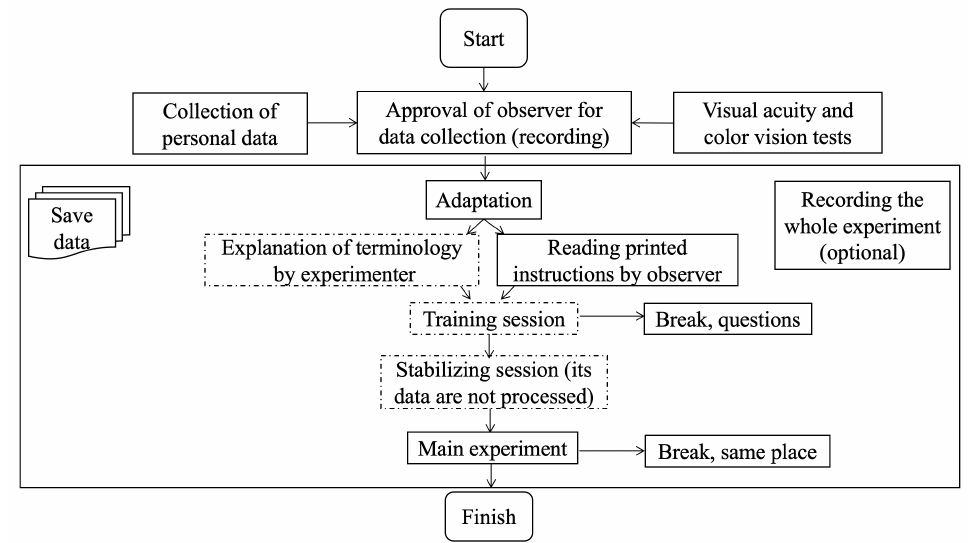
Figure 4. Our proposed framework for subjective quality assessment of 2.5D prints. Parts with dashed dots are optional. We included optional training and stabilizing sessions following the ITU [23]